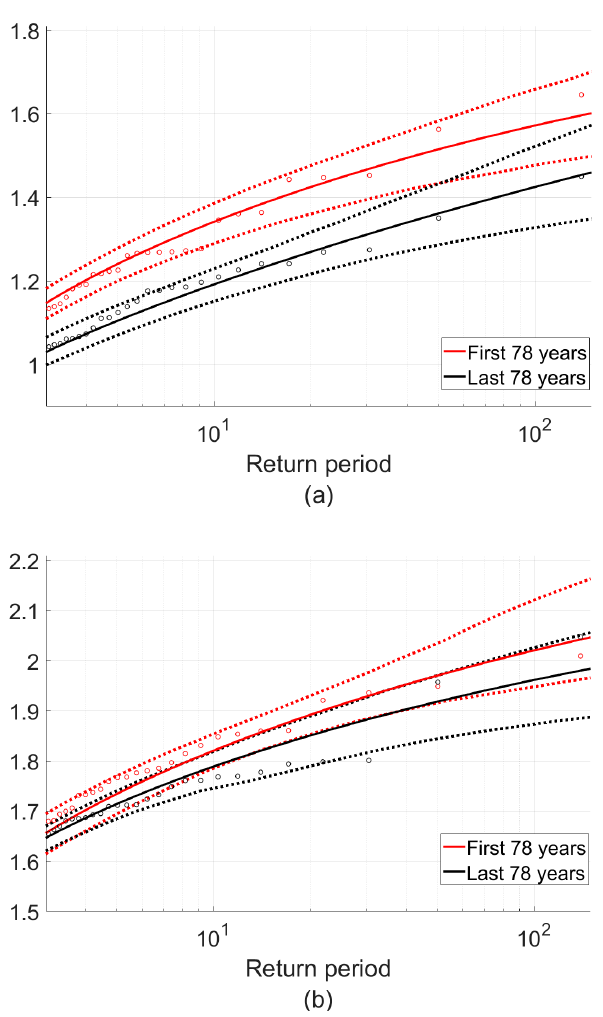
Figure 5. ( a ) Return period curve for exceedance of negative surges (absolute value), with data divided into older and more recent periods; ( b ) return period curve for exceedance of negative water level, similarly. All cases show 95% confidence intervals with dashed lines.